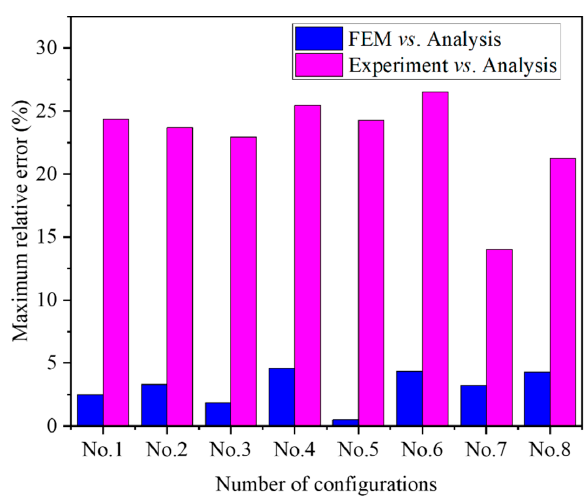
Figure 9. The maximum relative error value.